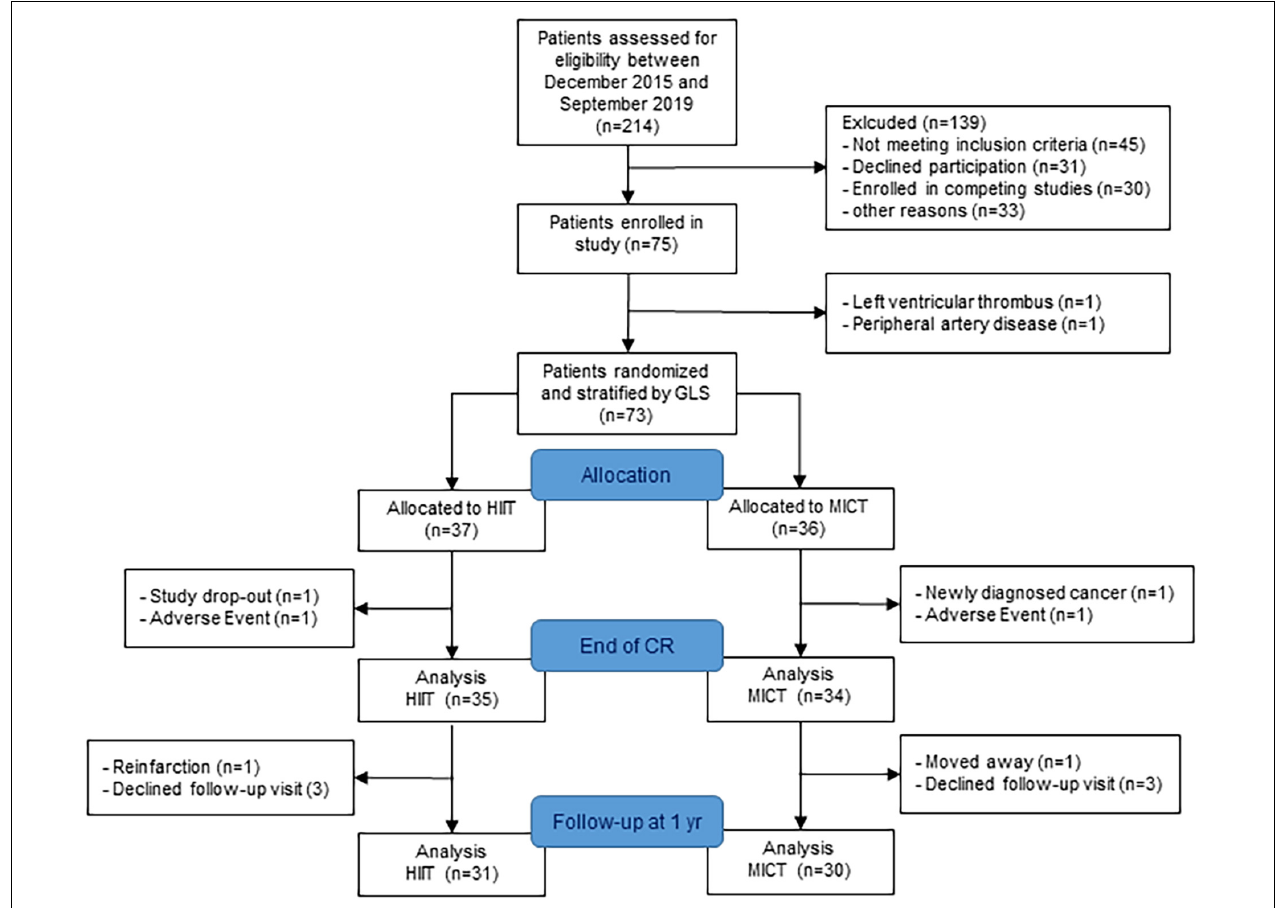
FIGURE 2 | Patient flow. GLS, global longitudinal strain; HIIT, high-intensity interval training; MICT, moderate-intensity continuous training; CR, cardiac rehabilitation.